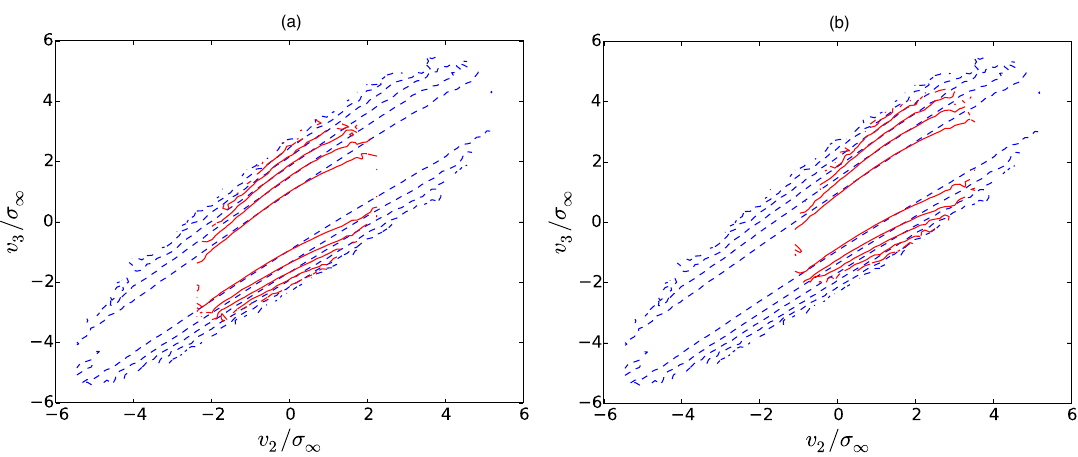
Figure 14. ( a ) examination of the Markov property (28) from DNS of the nonlocal case for ∆ r = 2.2 λ and v 1 = 0 via a logarithmic contour plot. ( b ) same as in ( a ), but for v 1 = σ ∞ . The shape of the conditional PDF (red) does not change significantly in comparison to ( a